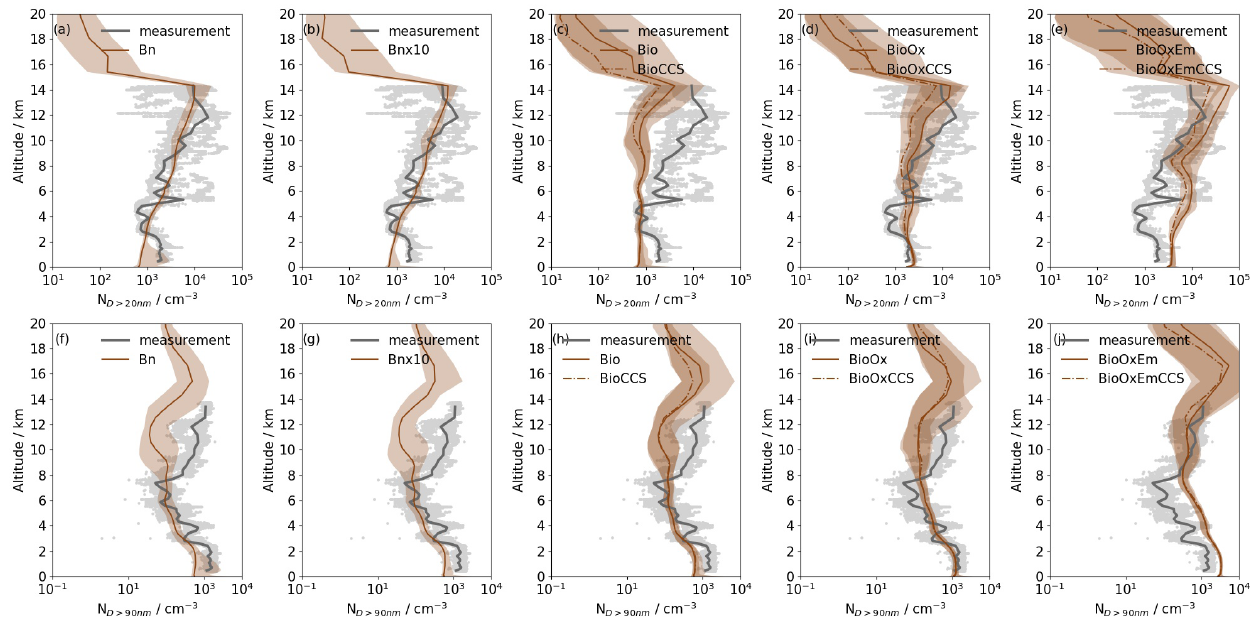
Figure 4. The observed and modelled vertical profiles of median number concentrations of particles with diameters > 20nm ( N D> 20nm , a – e ) and > 90nm ( N D> 90nm , f – j ). The observations are shown as grey dots and a grey line (repeated for all panels). The grey dots are individual observations from ACRIDICON–CHUVA flight AC11 (16 September 2014) with a time resolution of 1min, and the thick grey lines are the medians of the observations binned within the same height ranges as the regional model levels. The modelled results are from the various regional simulations averaged from 00:00UTC on 17 September to 23:00UTC on 18 September 2014, (a) and (f) Bn, (b) and (g) Bn × 10, (c) and (h) Bio and BioCCS (dashed line), (d) and (i) BioOx and BioOxCCS (dashed line), and (e) and (j) BioOxEm and BioOxEmCCS (dashed line). The shading represents 2.5% and 97.5% percentiles from the modelling